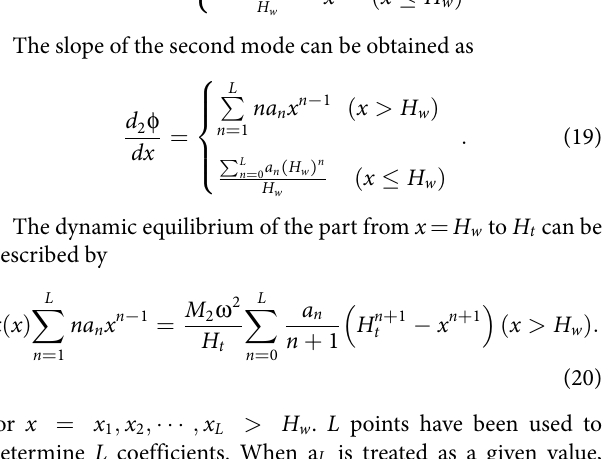
Frontiers in Built Environment |